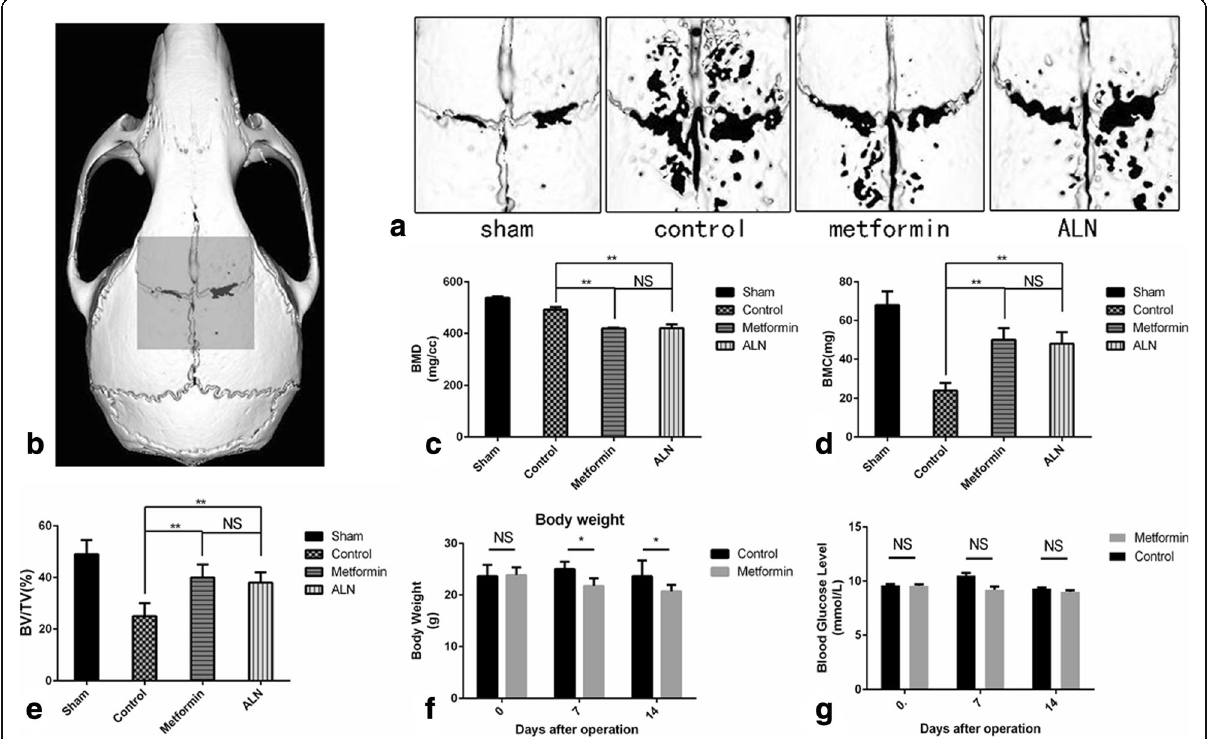
Fig. 3 Metformin attenuated particle-induced mouse calvarial osteolysis without changing the blood glucose level. a Three-dimensional images from micro-CT scans of mouse calvaria, showing evidence of resorption pits along the suture lines in mice in which UHMWPE particles were implanted in comparison with representative images from the metformin- and ALN-treated groups. b ROI selected for quantitative analysis of BMD ( c ), BMC ( d ), and BV/TV ( e ) in each group. f Changes in body weight after operation at days 0, 7 and 14. g Comparison of blood glucose levels between groups *** P < 0.001; ** P < 0.01; * P < 0.05; NS, not significant, P >